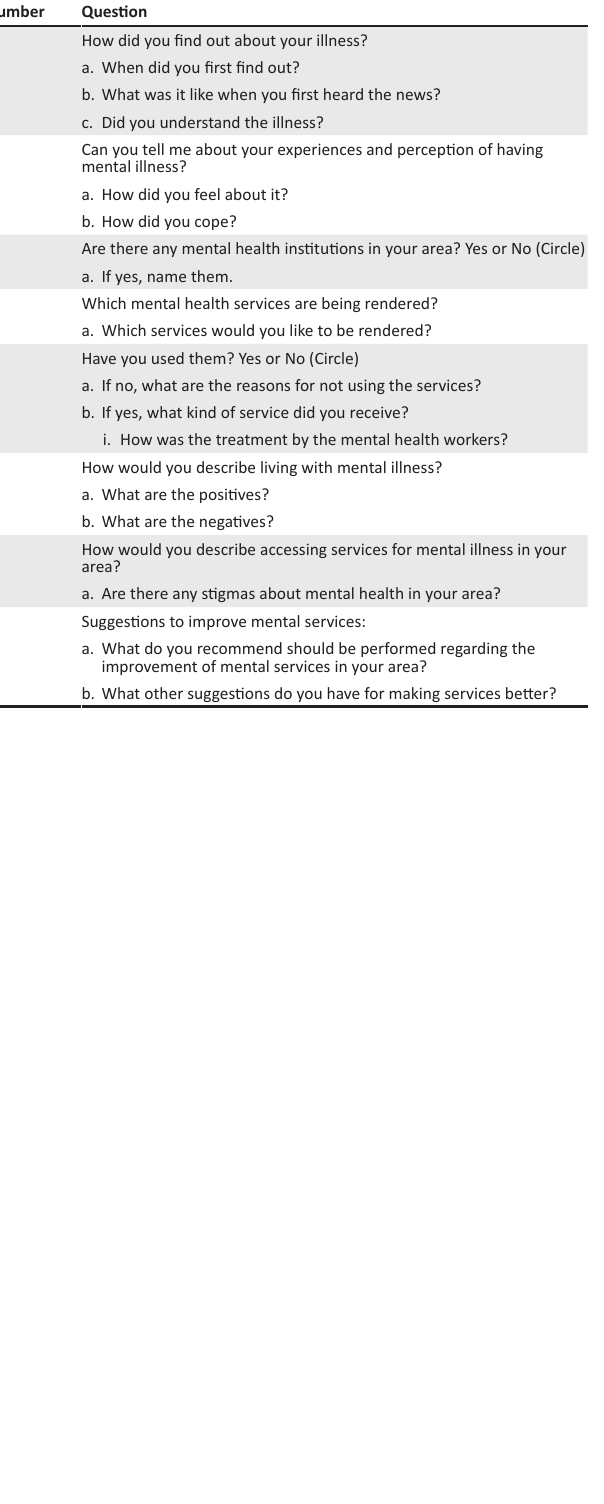
TABLE 1-A1: Interview